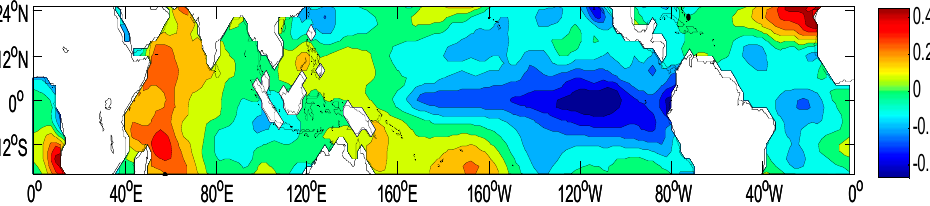
Figure 16. Composite of the June − July mean SST anomalies (°C) for extreme precipitation years.